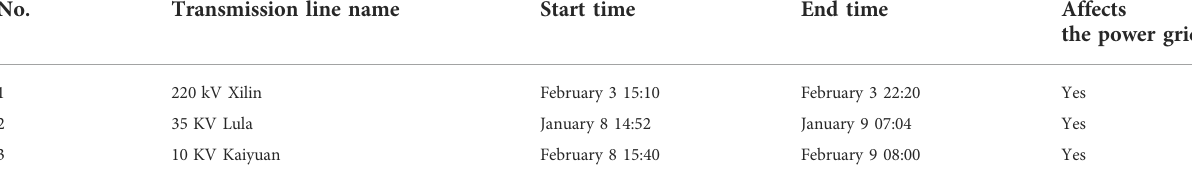
TABLE 2 Manual record of wild fi